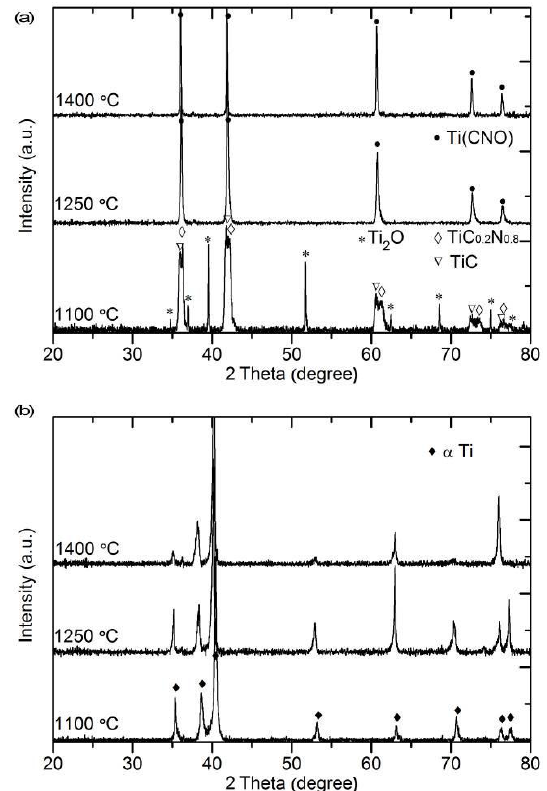
Figure 6. X-ray diffraction (XRD) patterns of the as-sintered small Ti compacts ( a ) on the surface and ( b ) cross-sections of compact interior. The compact was sintered for 4 h at 1100, 1250 and 1400 C, respectively.